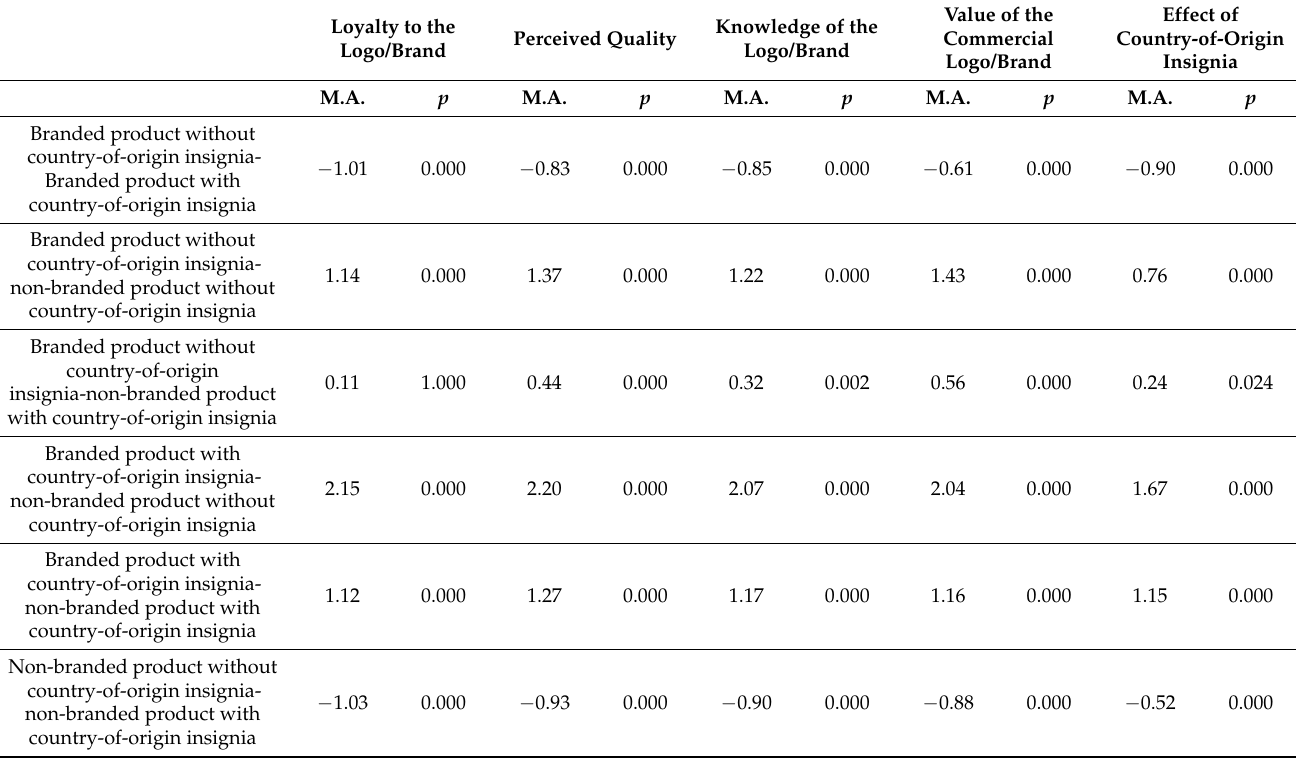
Table 4. Post-hoc